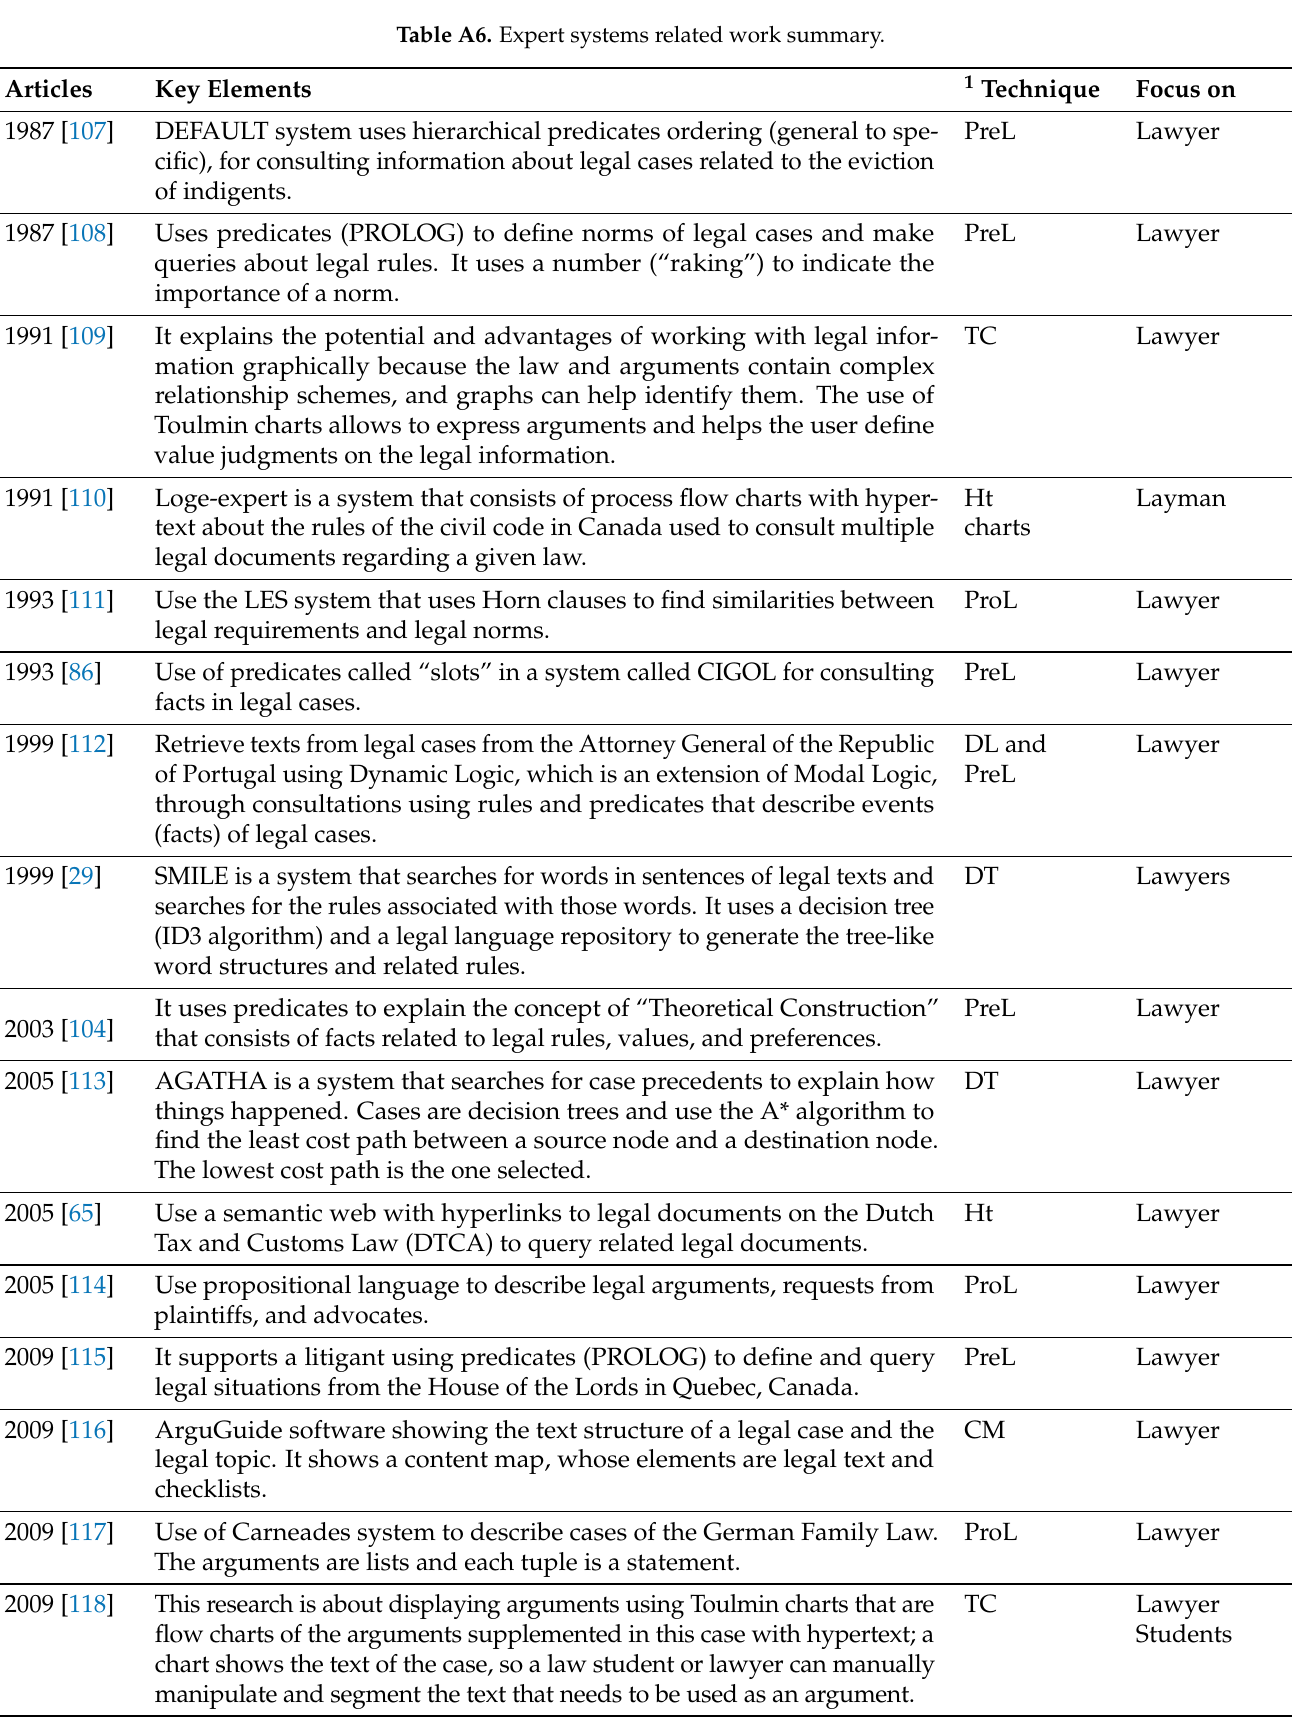
Table A6. Expert systems related work